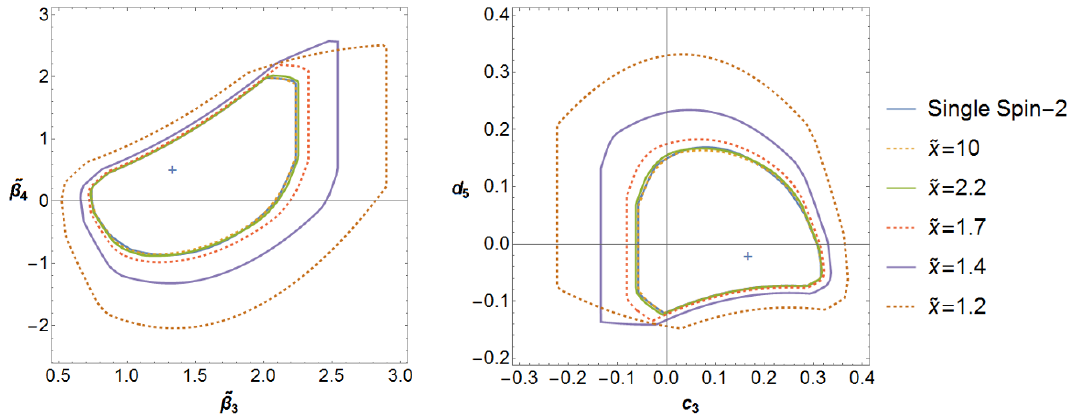
Figure 15 . The allowed parameter regions in the case of a (cid:12)xed scaling (cid:13) = ~ x 2 for di(cid:11)erent values of ~ x , for ~ (cid:11) 3 = ~ (cid:11) 4 = 0. For large ~ x (as in the limit (6.8)) the allowed region reduces to that of a single massive spin-2 (cid:12)eld. Decreasing ~ x makes the island increase. Left: the allowed region in ( ~ (cid:12) 3 ; ~ (cid:12) 4 ) plane. Right: the allowed region in ( c 3 ; d 5 ) plane, where ~ (cid:12) 3 = (cid:0) 4 c 3 + 2 and ~ (cid:12) 4 = (cid:0) 8 d 5 (cid:0) 4 c 3 +